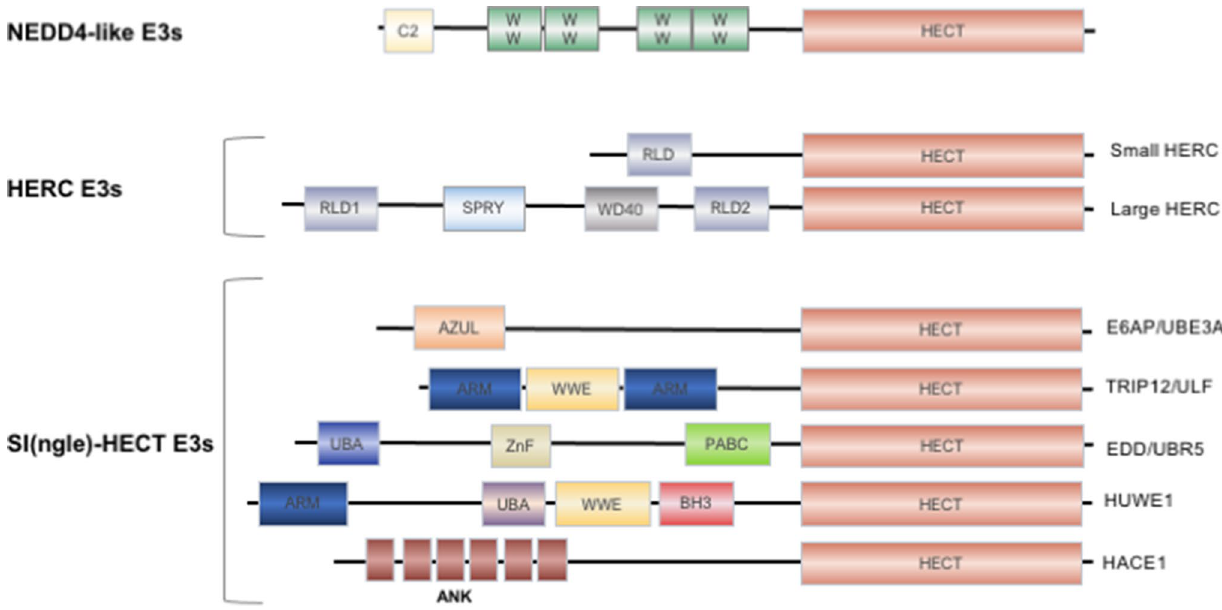
Fig. 2 Structural features of HECT ‐ type E3 enzymes. All the family members share the presence of the catalytic HECT domain, which is located at the C-terminus. According to their N ‐ terminal protein–protein interaction domains, the HECT E3s have been divided into three subgroups. The NEDD4-like members contain an N ‐ terminal protein kinase C ‐ related C2 domain and two ‐ four central WW domains that mediate substrate recruitment. HERC E3s possess a single (small HERCs) or more (large HERCs) RCC [regulator of chromatin condensation 1]-like domain (RLDs) preceding the HECT domain. Large HERCs contain additional domains, such as SPRY and WD40 domains. The SI(ngle) ‐ HECT subfamily is composed of varied number and types of domains such as armadillo repeat ‐ containing domain (ARM), amino ‐ terminal Zn ‐ finger of Ube3a ligase domain (AZUL), WWE domain (WWE), Bcl-2 homology 3 domain (BH3), ankyrin repeat ‐ containing domain (ANK), polyadenylate ‐ binding protein C ‐ terminal domain (PABC), ubiquitin-associated domain (UBA), and zinc finger domain